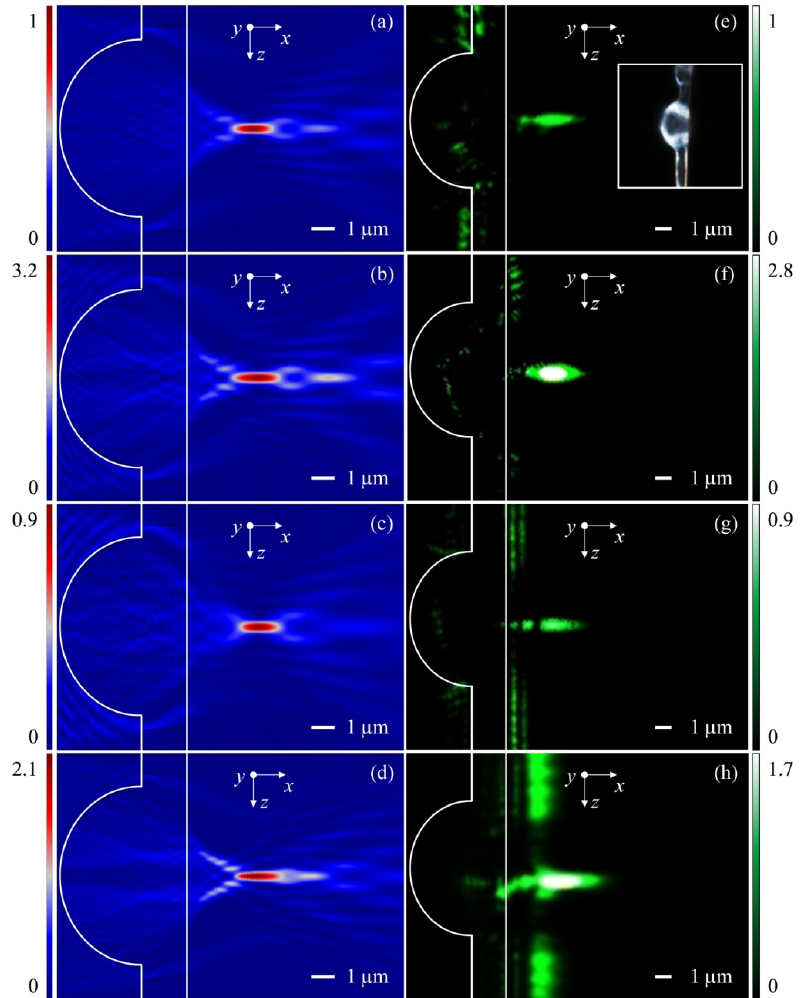
Figure 2. Numerical results of normalized power flow patterns for the ( a ) dielectric, ( b ) gold-coated, ( c ) silver-coated, and ( d ) copper-coated dome microlenses; and raw experimental images of the ( e ) dielectric, ( f ) gold-coated, ( g ) silver-coated, and ( h ) copper-coated dome microlenses. The incident wavelength was 532 nm for all the dome microlenses. The inset is a microphotograph of the spider-silk-based dome microlens.